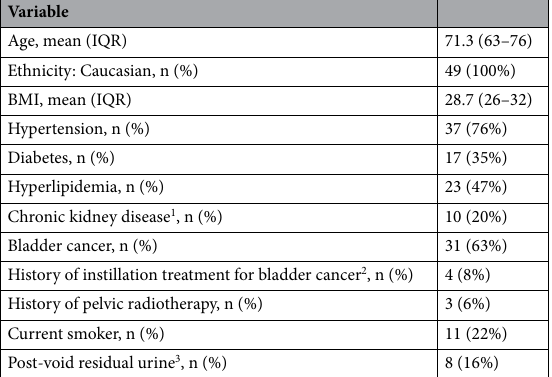
Table 1. Clinical and demographic variables of the study population (n = 49). IQR interquartile range, BMI body mass index. 1 Estimated glomerular filtration rate (CKD-EPI eGFR) < 60 mL/min. 2 Mitomycin-C, epirubicin or Bacillus Calmette-Guérin. 3 40 mL or more left in the bladder after spontaneous voiding as measured by